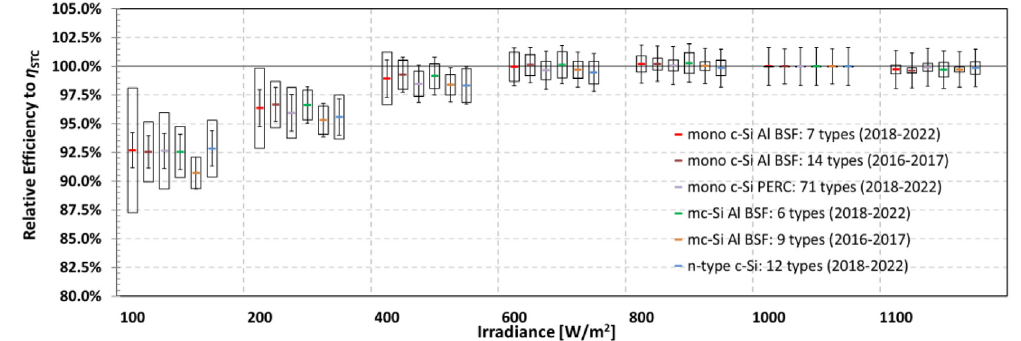
Fig. 3. Relative ef fi ciency deviation (to STC) against irradiance for different module types at 25 ° C and spectral distribution of AM1.5G. Boxes represent the standard deviation of technology variation ( k =2) and error bars represent the measurement uncertainty ( k =